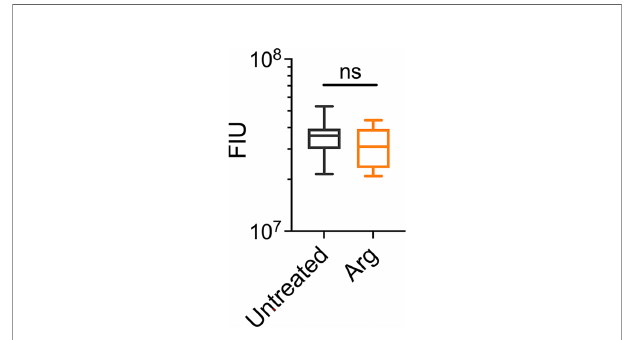
FIGURE 5 | Arginine treatment does not lead to reduced bio fi lm biomass. 7 day S. gordonii bio fi lms were treated with either PBS (untreated control) or with 4% arginine for 2min. Bio fi lm biomass was removed from the coupon surface and labelled with Syto 9. Syto 9 signal is presented as fl uorescence intensity units (FIU). N = 4; ns indicates no signi fi cant difference.